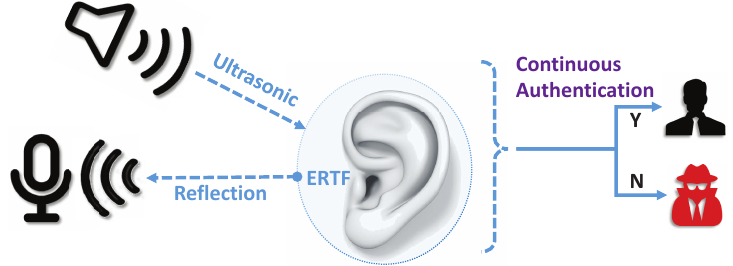
Figure 1. MetaEar, an acoustic side channel continuous authentication